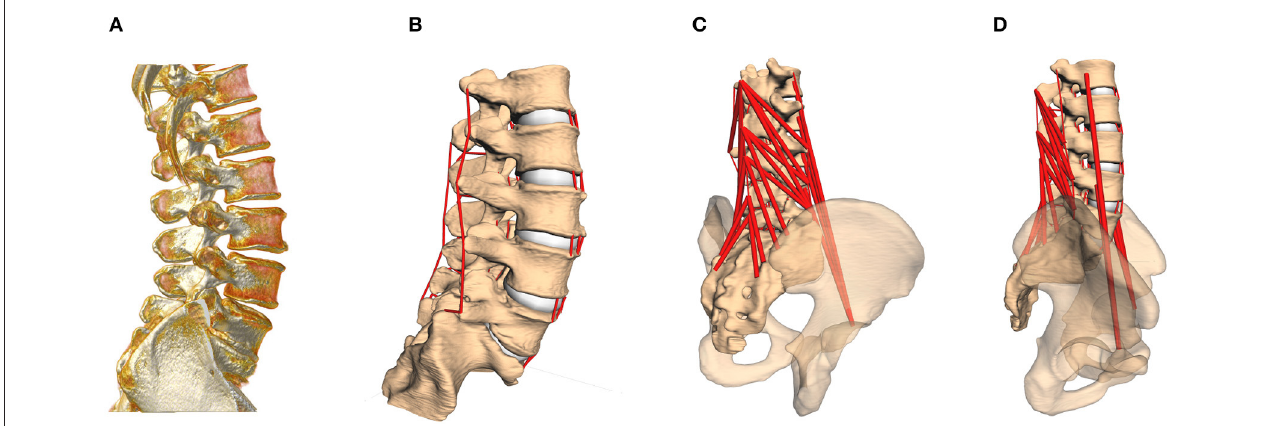
FIGURE 1 | (A) CT image of the lumbar spine, rotated to standing position. (B) Computer model based on the subject-specific CT geometries, including passive structures [intervertebral disks (IVDs), facet joints and ligaments]. (C,D) In a last step, active force elements, muscles, are inserted into the model according to individual landmarks. The pelvis serves as origin for the M. psoas major